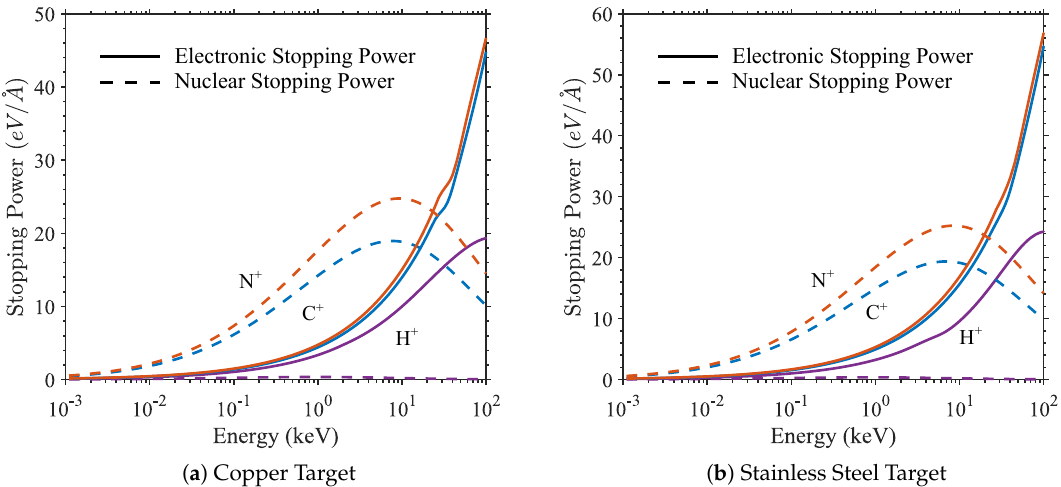
Figure 3. Surface electronic and nuclear stopping powers as a function of impact energy for H + , C + , and N + ions. Values were obtained with SRIM